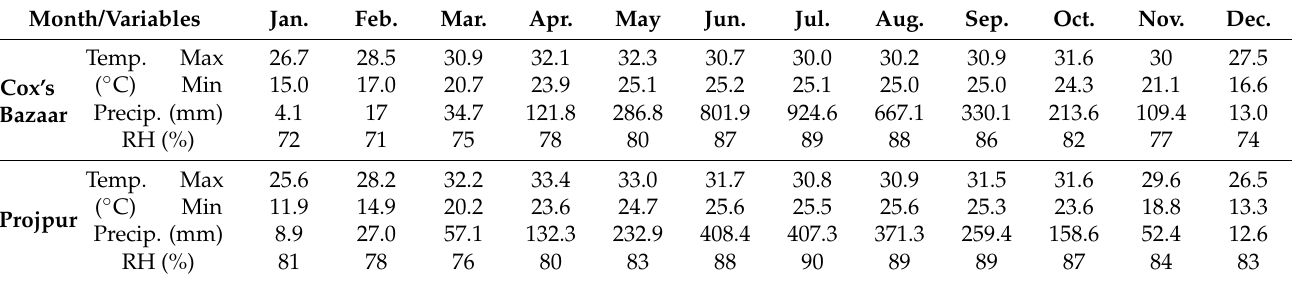
Table 1. Monthly climate data of Cox’s Bazaar and